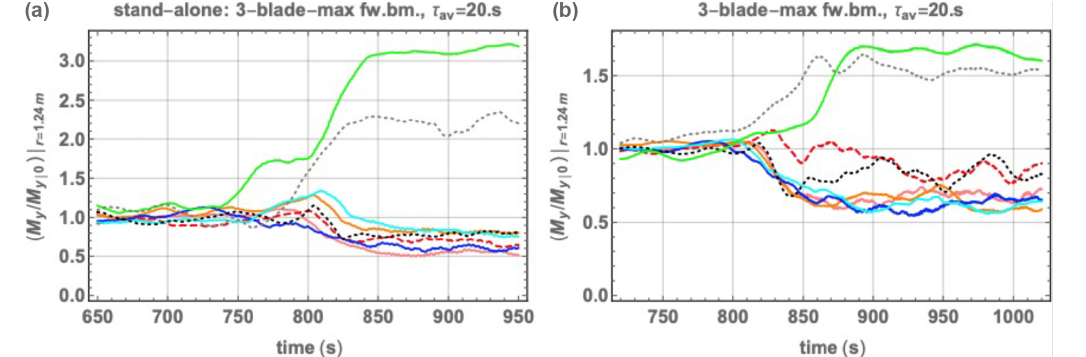
Figure 19. Flap-wise blade-root bending moment M brfw (maximum of three blades); normalized by pre-ramp values. (a) Stand-alone CMM/Flex5 simulations. (b) Coupled LES outputs for first (upwind) turbine. Color legend as in Figs. 11–12, 14–18, and 22–23.